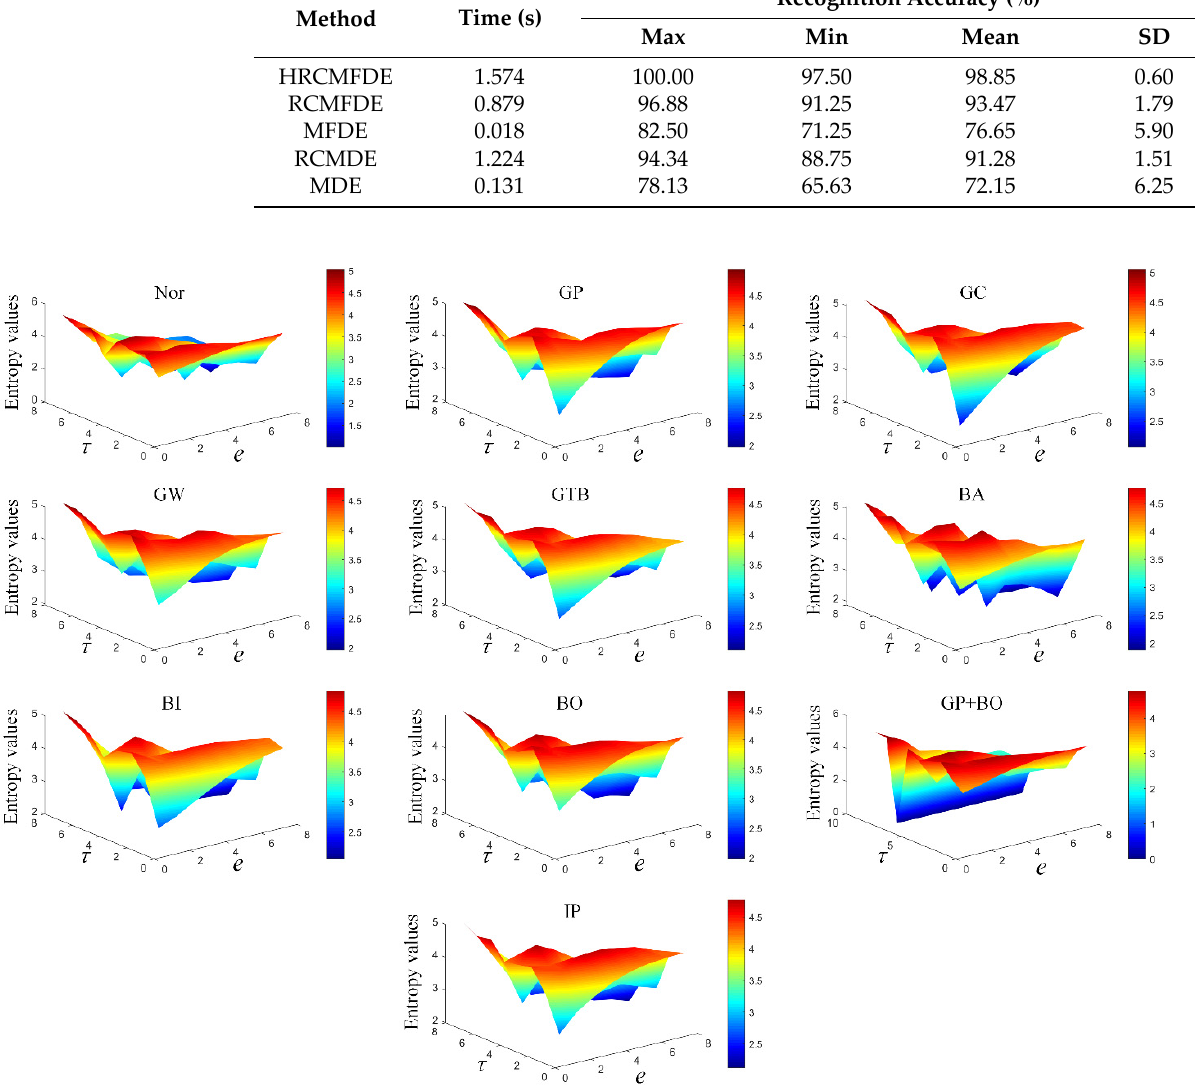
Figure 19. Raw fault features corresponding to different states.